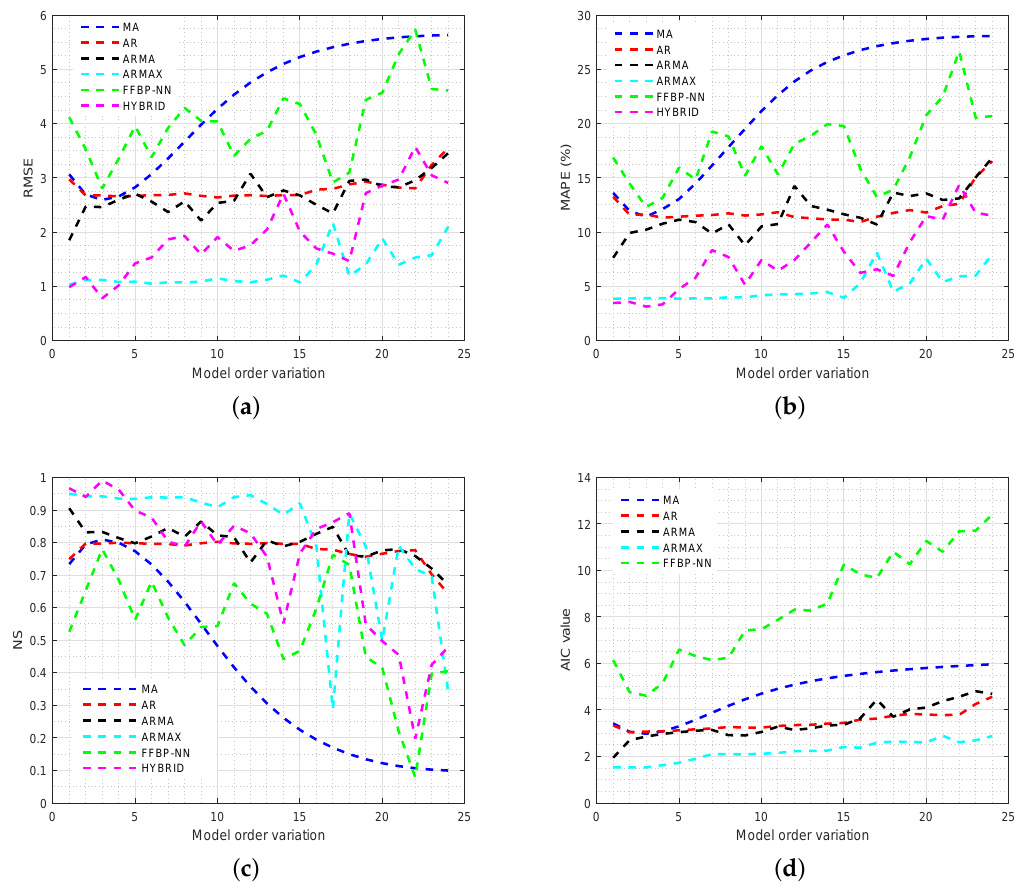
Figure 5. Comparative assessments of the STWD forecasting models using ( a ) RMSE; ( b ) MAPE; and ( c ) NS. ( d ) Estimated quality of AR, MA, ARMA, ARMAX, and FFBP-NN using AIC